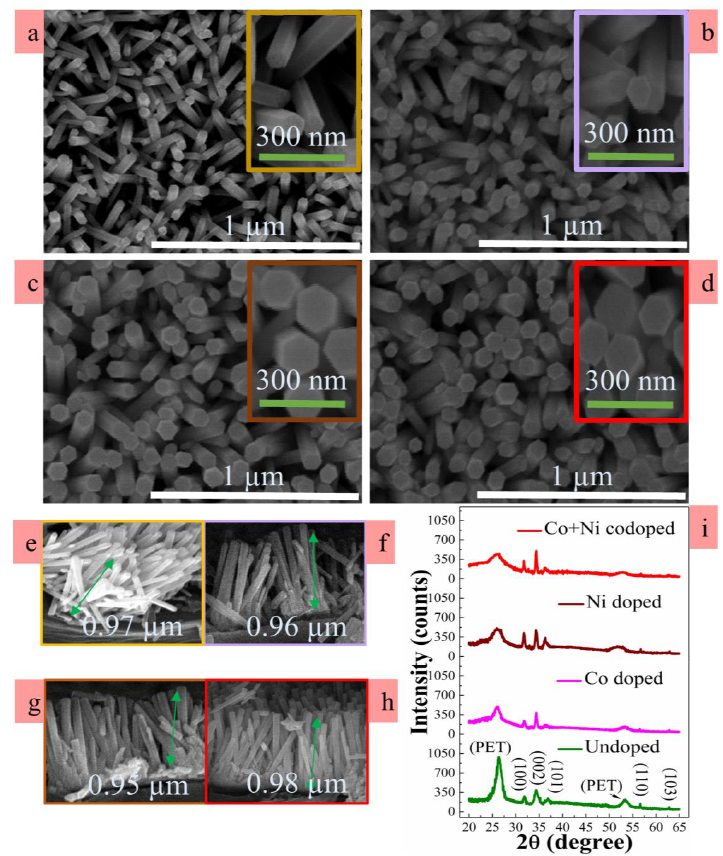
Figure 3. Top views of SEM for ( a ) undoped, ( b ) Co doped, ( c ) Ni doped, and ( d ) Co-plus-Ni codoped ZnO NRs grown on PETs. Cross-sectional SEM views of as-grown ZnO NRs for each case of ( a – d ) are also shown in ( e ), ( f ), ( g ), and ( h ). X- ray diffraction (XRD) 2θ patterns of the NRs under different doping conditions are shown in ( i ).